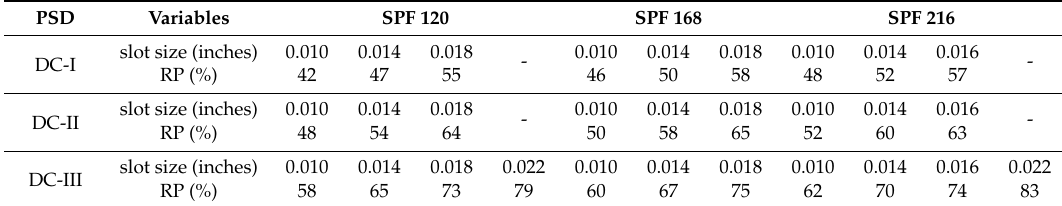
Table 4. Retained permeability for di ff erent